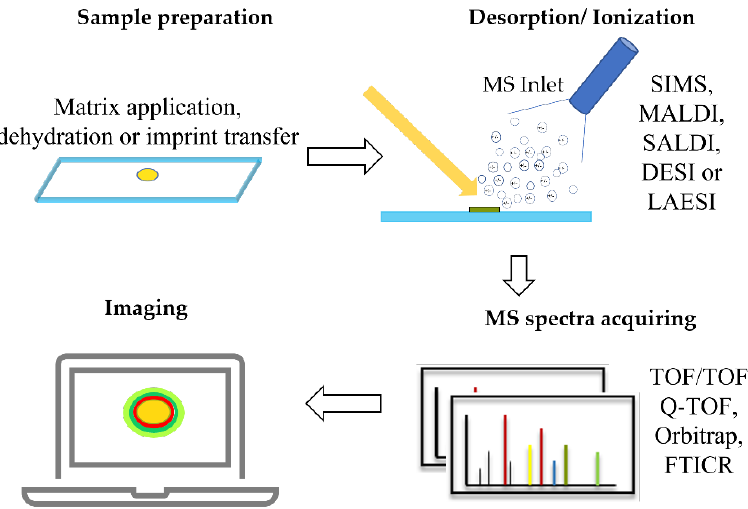
Figure 1. Microbial mass spectrometry imaging- related papers on Web of Science™ from 2002– 2021.